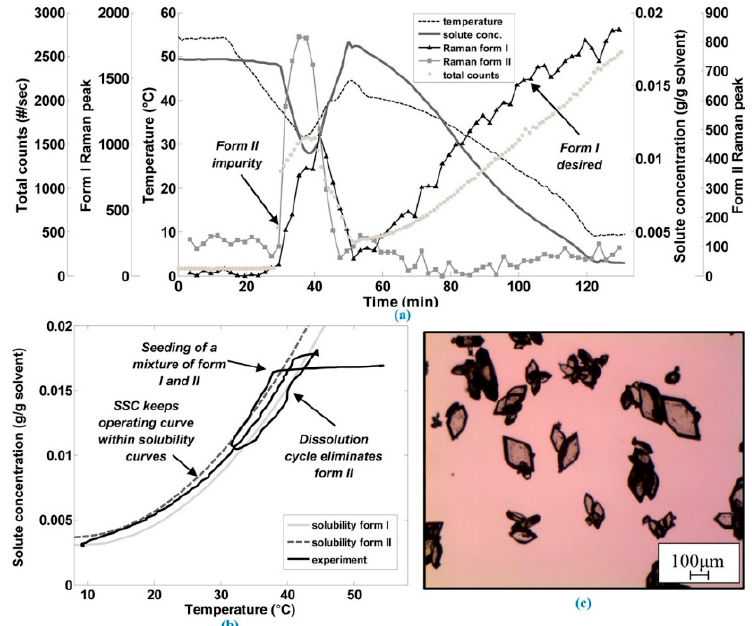
Figure 10. Time evolution of temperature, concentration, Raman signals for forms I and II, and total counts/s from FBRM ( a ); an operating curve in the phase diagram ( b ); microscope image of the resulted dried crystals indicating only the presence of form I with no trace of needle-shaped form II crystals in the product ( c ). (Caption and figure reprinted with permission from Reference [40]).